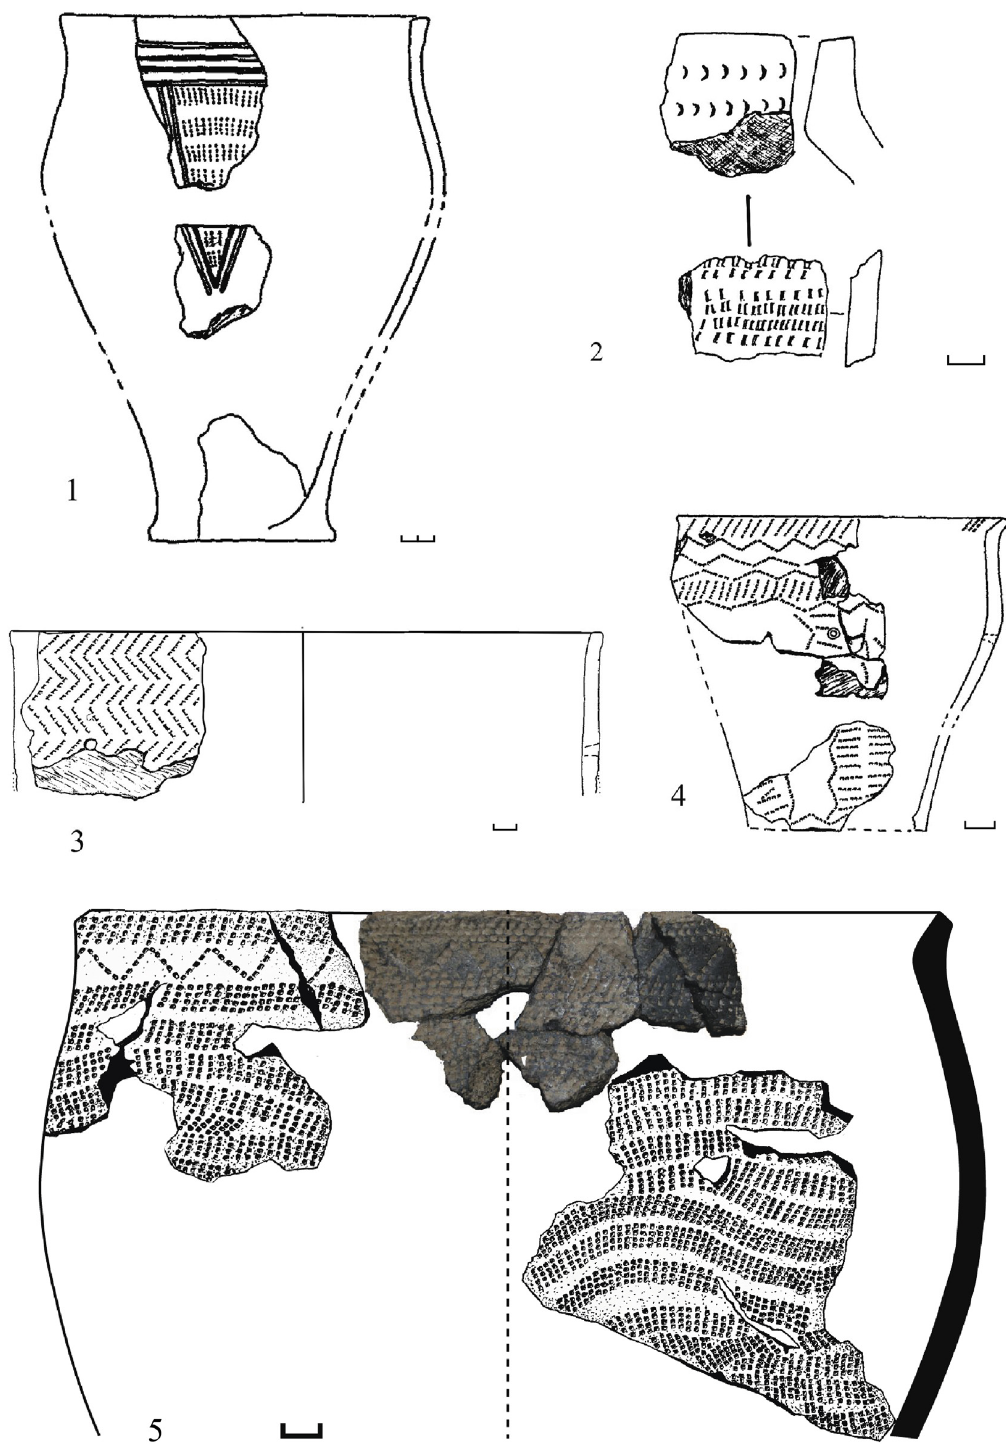
Figure 3: Earliest comb - ornamented pottery from Babino 3 ( 1 ) , Semenovka 1 ( 2 – 4 ) , and Chapaevka ( 5 )